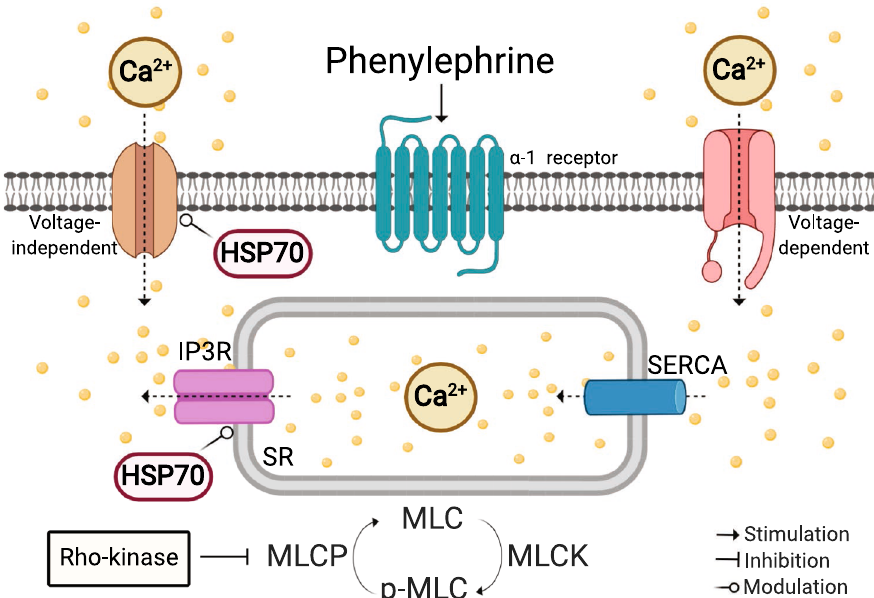
Figure 8. Proposed mechanism of HSP70 in aorta stimulated with phenylephrine. Pharmacological blockade of 2 + HSP70 modulates Ca handling mechanisms in aorta stimulated with phenylephrine potentially via crosstalk 2 + with ( a ) IP3r-mediated Ca release from the SR (phasic) and ( b ) voltage-independent Ca Ca 2 + influx (tonic). Created with